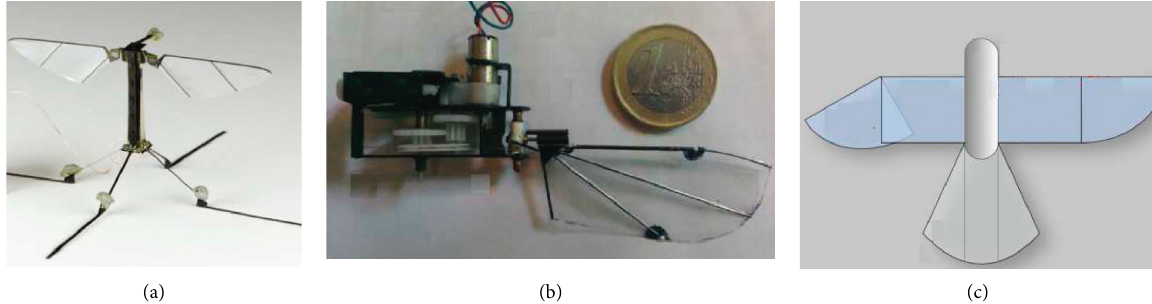
Figure 1: Several flapping wing robots. where (a) :the robot designed by Chirarattananon; (b) :the robot designed by Leys; (c) :the robot designed by